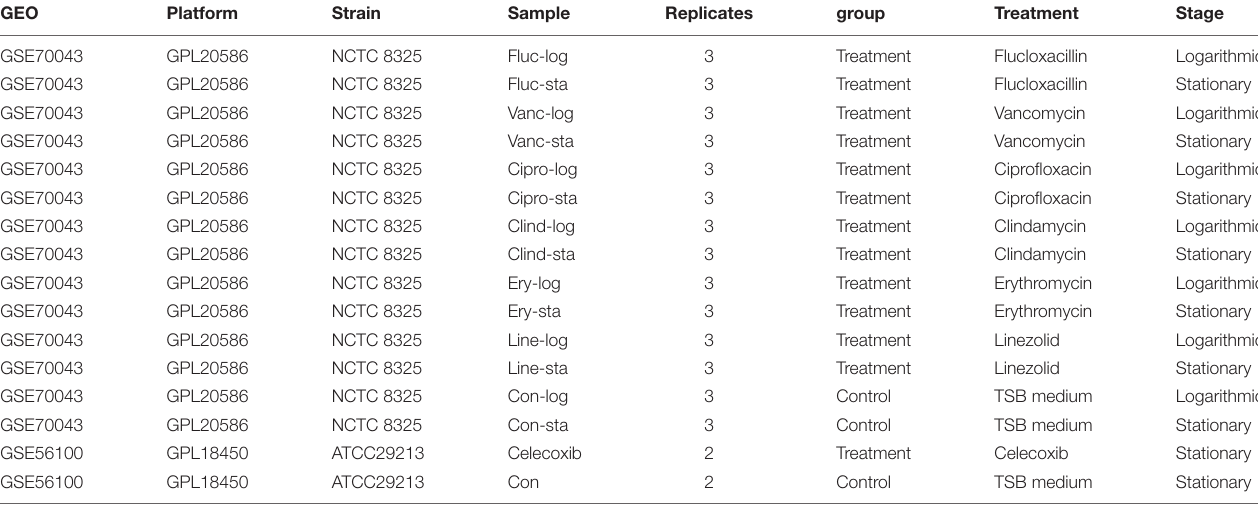
TABLE 1 | Details for GEO